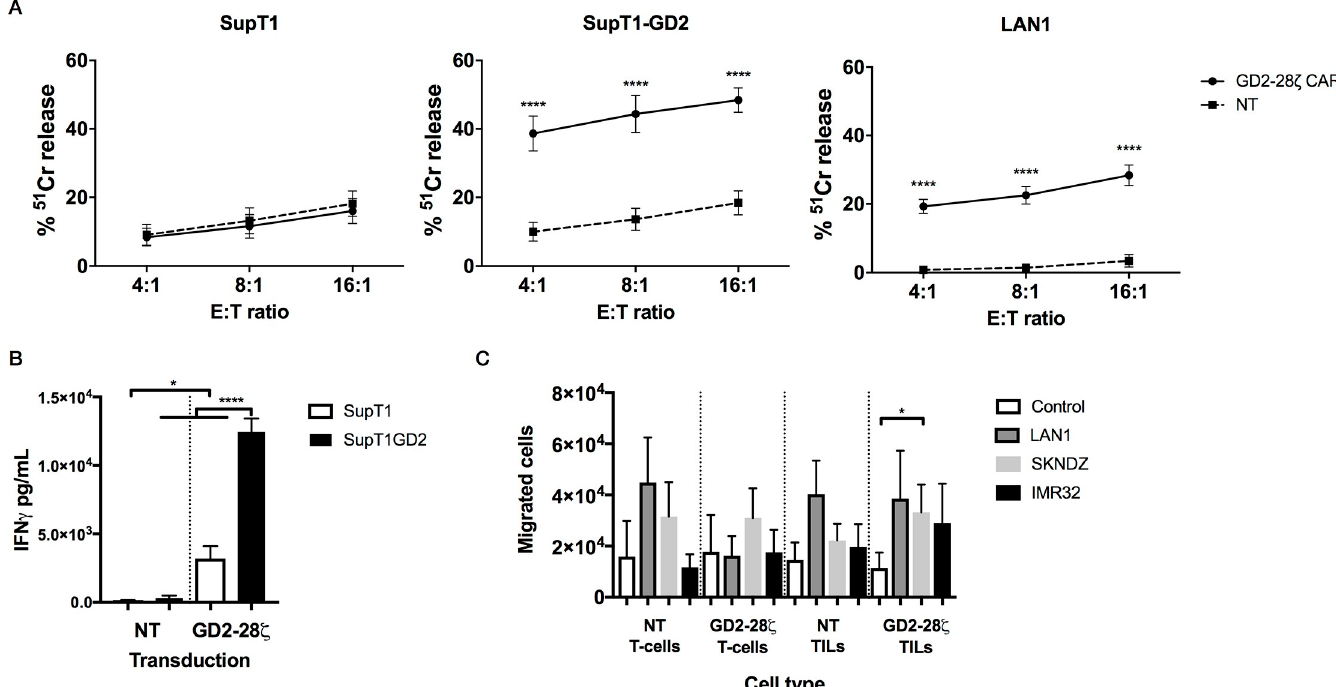
Fig 6. Functional analysis of chimeric antigen receptor expressing TILs. TILs were transduced to express an anti GD2-28 z CAR with a mean transduction efficiency of 16.2 ± 2.8%. (A) Killing of GD2 - SupT1, GD2 + SupT1-GD2 and GD2 + LAN1 neuroblastoma cells by transduced and non-transduced (NT) TILs (n = 16). Killing of SupT1-GD2 and LAN1 was significantly enhanced by the presence of GD2-28 z (p = < 0.0001). Statistical analysis by 2-way ANOVA with Sidak’s correction for multiple comparisons. (B) IFN γ release by non-transduced and GD2-28 z transduced TILs in response to SupT1 or GD2-SupT1 (n = 8). Presence of the GD2-28 z CAR increases background IFN γ production (p = 0.011) but the presence of GD2 + SupT1-GD2 leads to much greater IFN γ release (p = < 0.0001). Statistical analysis by one-way ANOVA with Sidak’s correction for multiple comparisons. (C) Transduction with GD2-28 z does not reduce the migratory capacity of TILs towards neuroblastoma cell lines, as determined using a 24h trans-well assay with target cells in the bottom chamber and effectors in the top chamber.